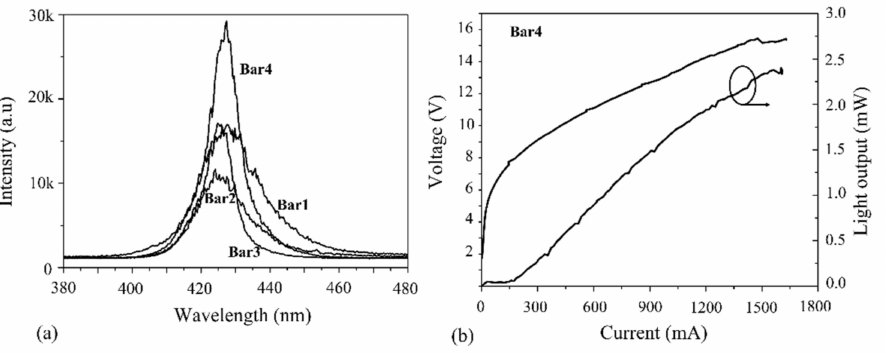
Figure 3. ( a ) EL spectrum at 10 kAcm − 2 current density for the selected bars shown in Figure 2b. ( b ) L-I-V measurement data for bar 4 under pulsed